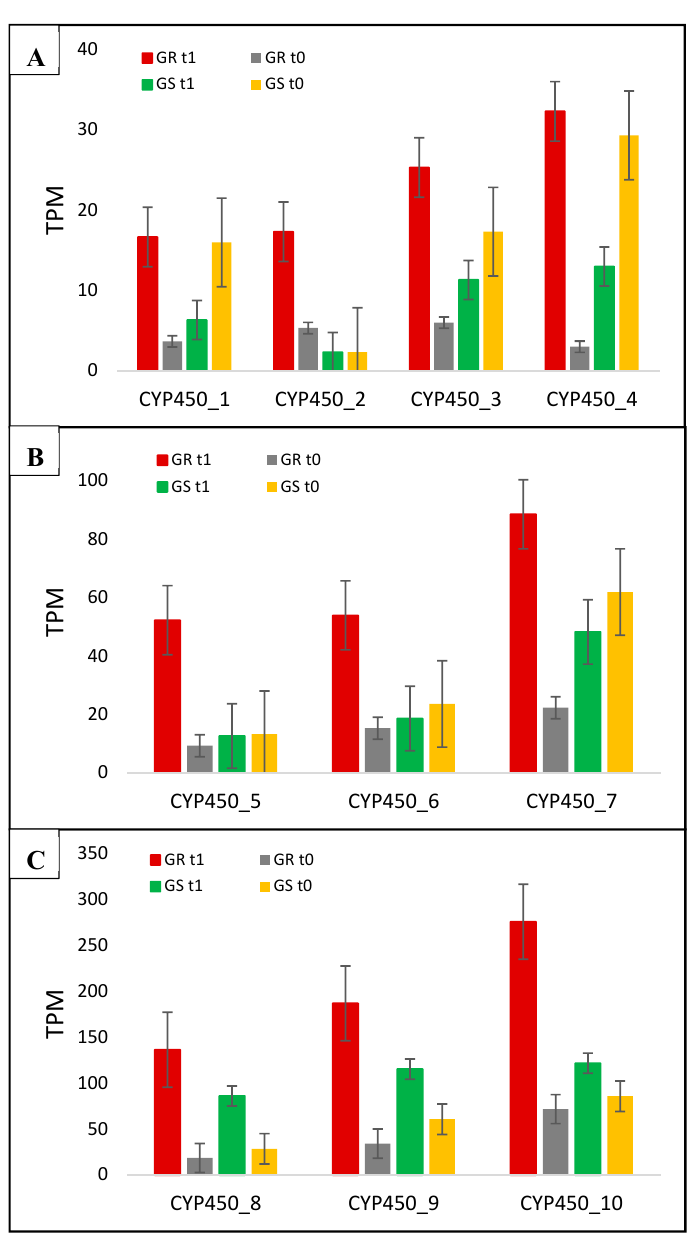
Figure 6. C. bonariensis transcriptome expression analysis (transcript reads per million mapped